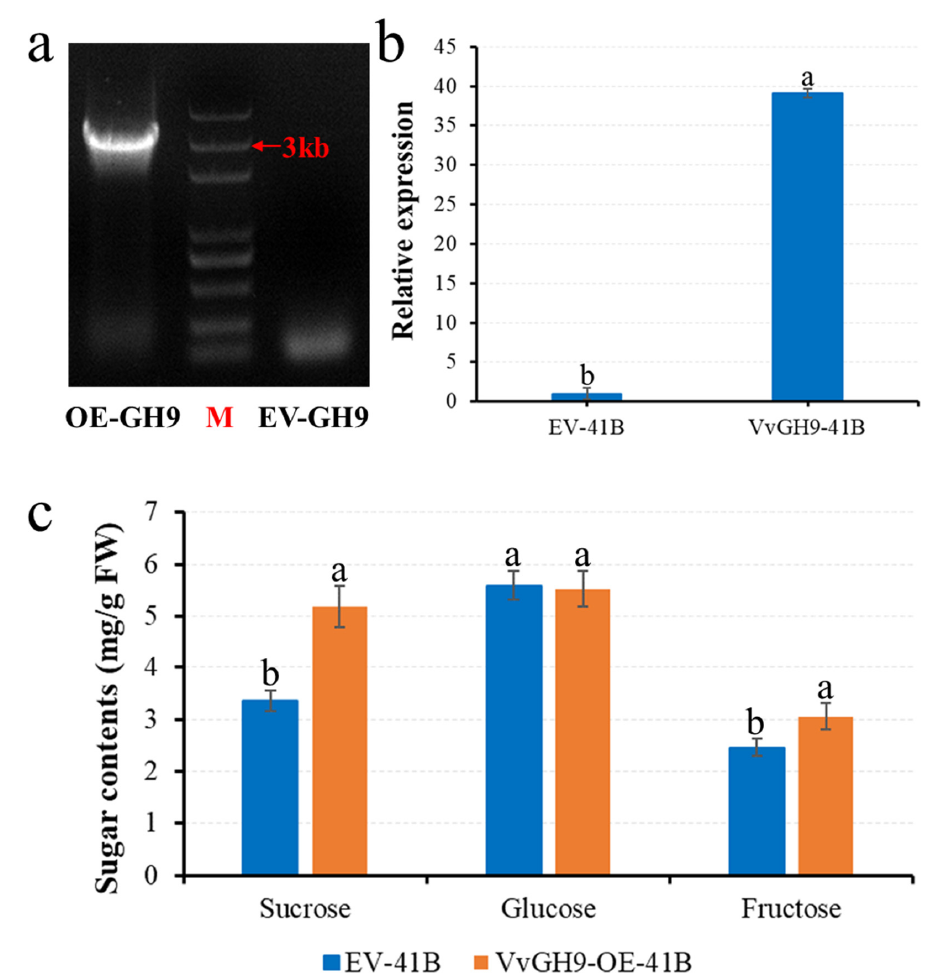
Figure 8. VvGH9 overexpression and phenotypic identification of grape calli. ( a ) Verification of VvGH9 insertion in the transgenic 41B calli. ( b ) The upregulation of GH9-OE in 41B calli was determined by qRT-PCR. ( c ) Analysis of sugar levels in EV and GH9-OE calli. FW: fresh weight. The letters above the bars indicated the significant differences by student’s t -test ( p < 0.05). Three biological replicates were analyzed, and the error bars represented the SD.